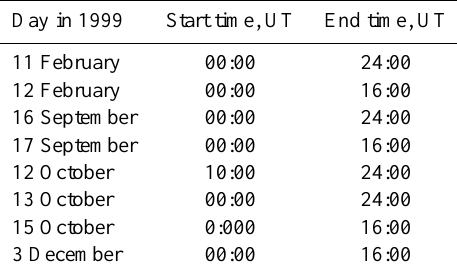
Table 2. Parameters A and B of the fit C S = A + B · V 2 EISCAT data at various